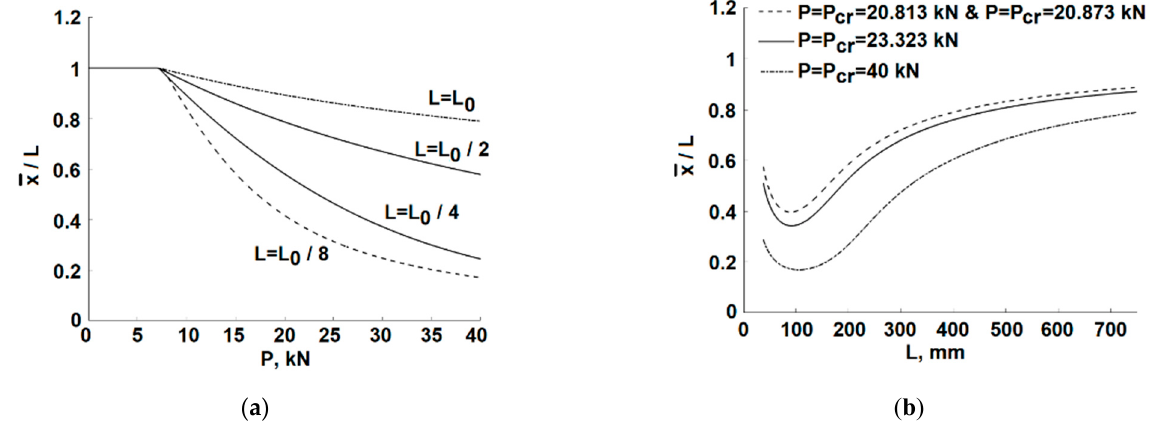
Figure 16. Boundary 𝒙(cid:3365) between the 1st and second bond-slip zones. ( a ) dependence on tensile load; ( b ) dependence on the bar length.